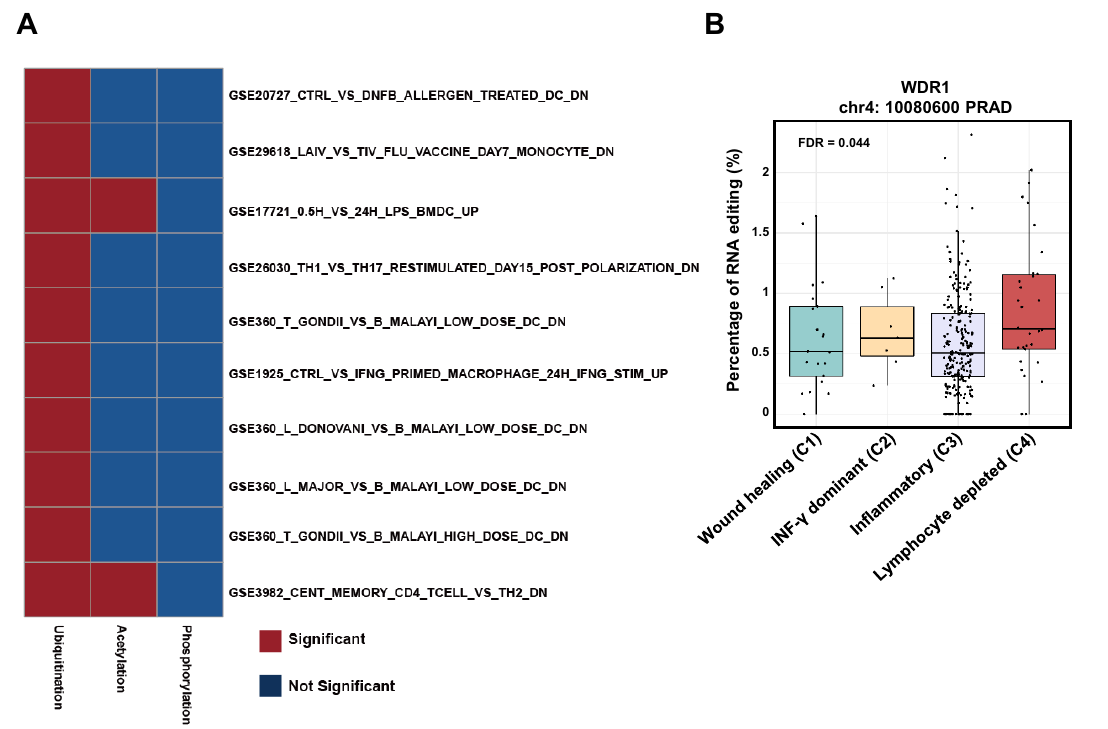
Figure 6. The enrichment analysis of nonsynonymous RNA editing on ubiquitination site. ( A ) The heatmap showing the enrichment of genes harboring nonsynonymous RNA editing in immune response pathway. ( B ) The boxplot demonstrating the editing level among immune subtypes in TCGA dataset. The P-value was computed by “aov” function in